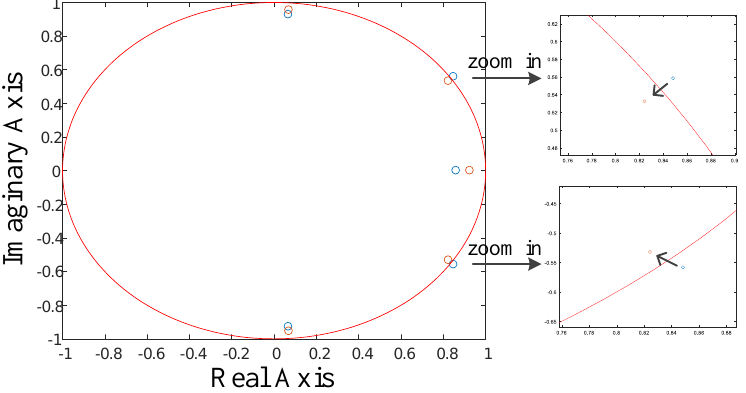
11 of 18 Figure 14. Bode diagram of P(z) under different load conditions. 4. System stabilization strategies